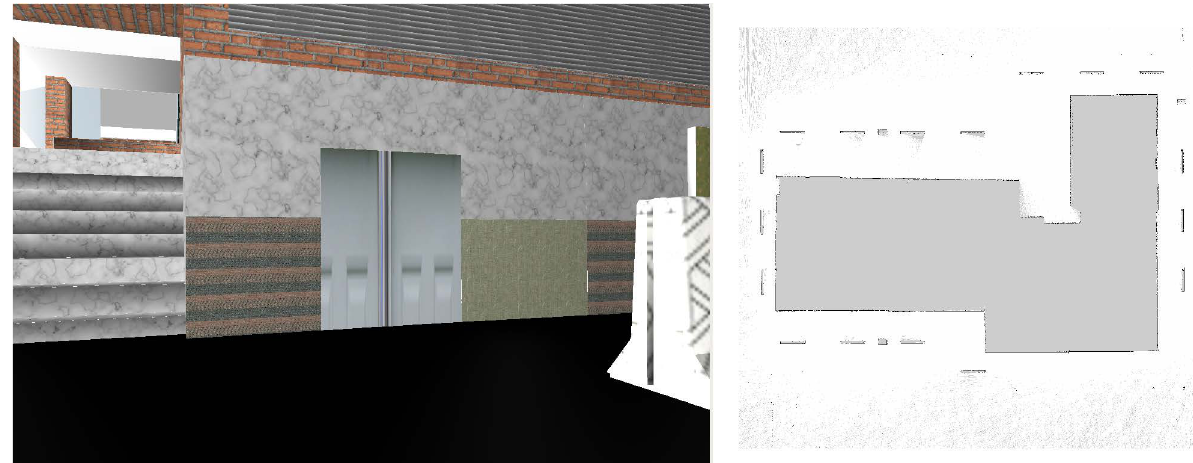
Figure 4. An example of a captured (simulated) image using a camera mounted on the simulated UGV/robot ( left ) and the map of the simulated world generated with SLAM technique using a LiDAR sensor on the robot ( right ).